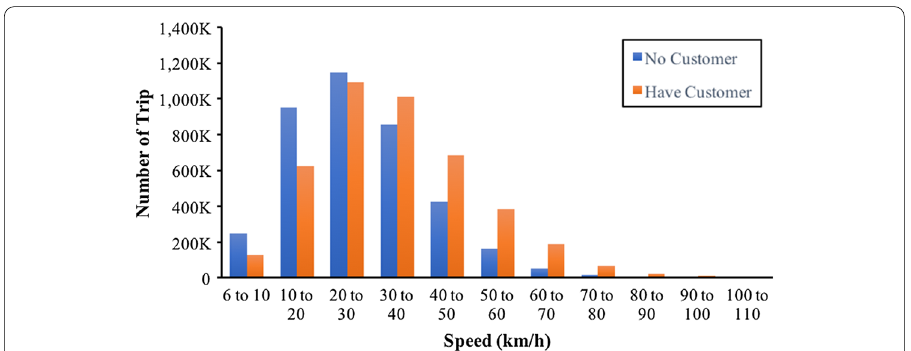
Fig. 4 Speed of taxicab trips